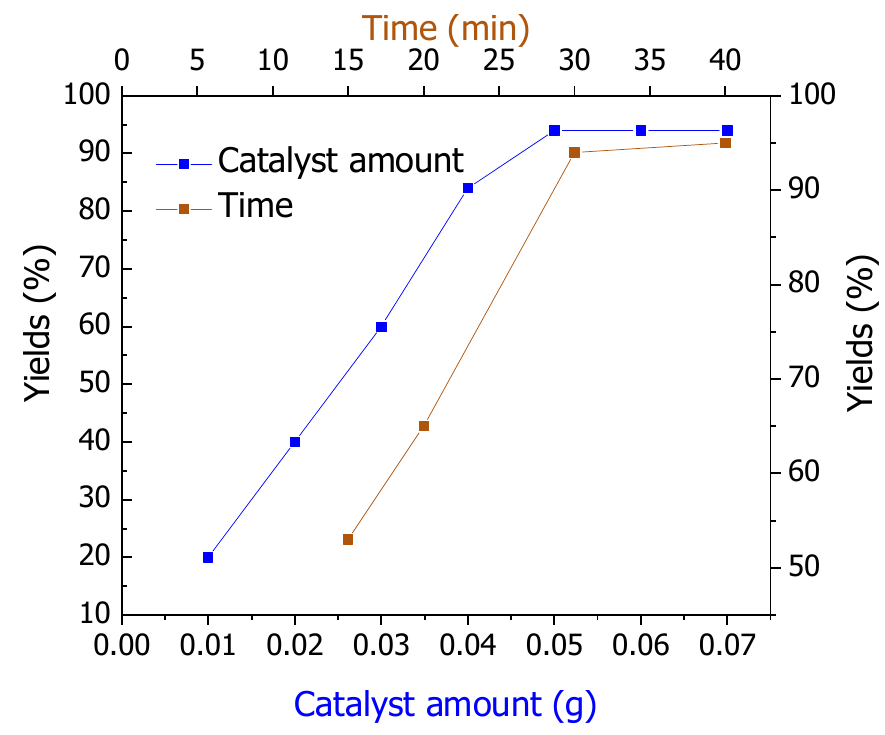
Figure 6. Influence of the amount of the Na 2 CaP 2 O 7 catalyst and reaction time on the synthesis of 2-amino-3-cyanopyridine 5a . Table 1. Optimization of reaction conditions for the synthesis of 2-amino-3-cyanopyridine 5a.